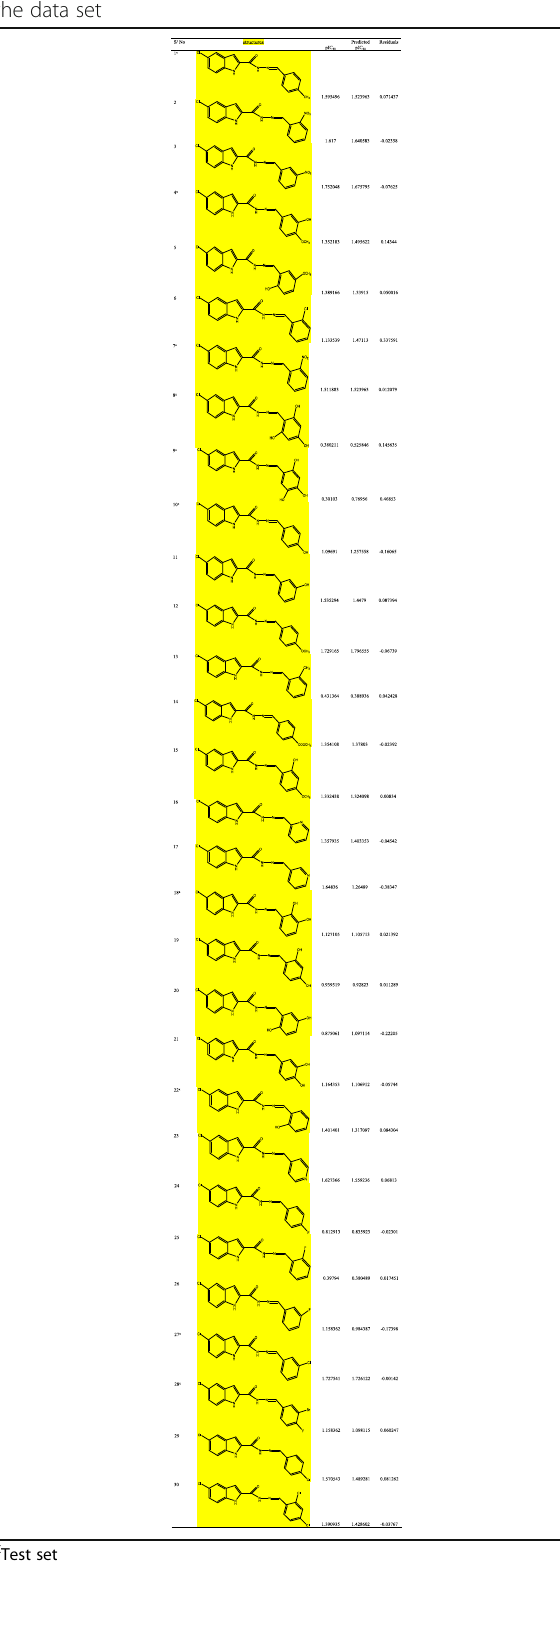
Table 4 The structures, pIC 50 , predicted pIC 50 , and residuals of the data